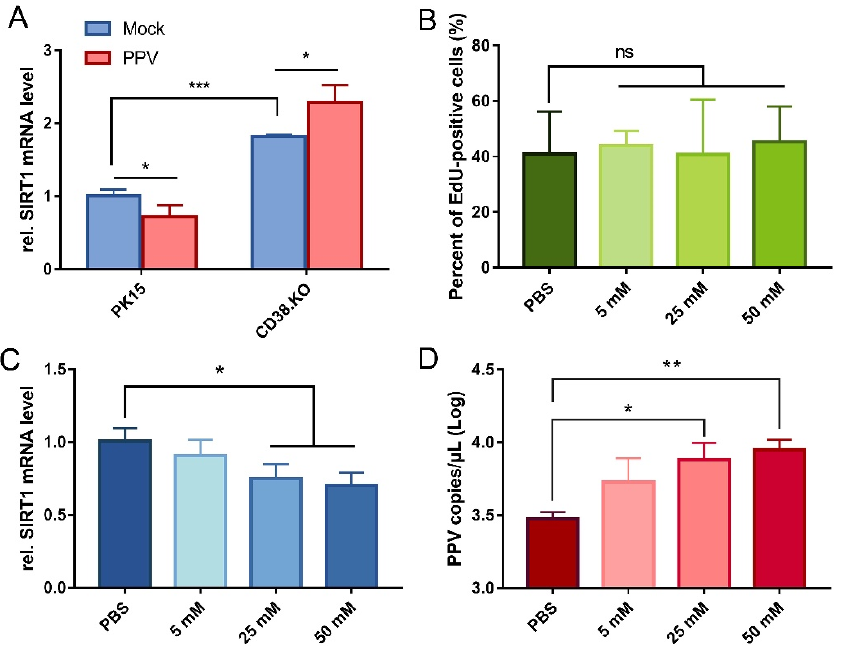
Figure 4. SIRT1 is inhibited by CD38 and is conducive to PPV infection. ( A ) Quantitative real-time RT-PCR was used to detect relative SIRT1 mRNA level in CD38 cells after PPV infection (MOI = 1, 24 hpi), and PK-15 cells were used as control. ( B ) CD38.KO cells treated with different concentrations of NAM continue to be cultured for 2 h after loading EdU. After the click reaction, at least 3 photos of each sample were taken by fluorescence microscope. The percentage of EdU-positive cells were calculated, respectively, the average value was taken as the final data, and the cells treated with PBS as the control. CD38.KO cells treated with different concentrations of NAM were infected with PPV (MOI = 1, 24 hpi). The mRNA level of SIRT1 ( C ) and the copy number of PPV virus ( D ) in the cells were detected. The cells treated with PBS were used as the control. *: p < 0.05, **: p < 0.01, ***: p < 0.001, and ns: not significant.